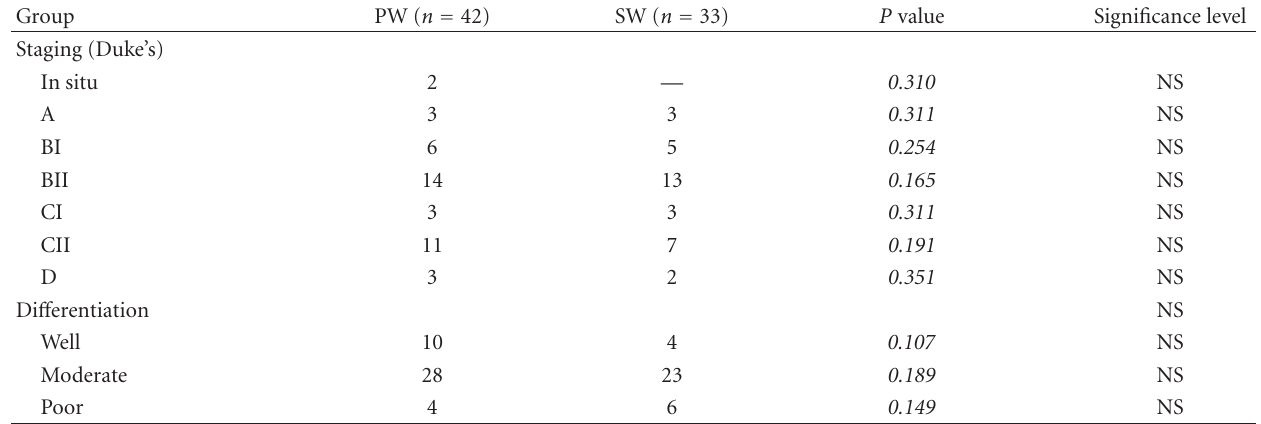
Table 3: Staging and di ff erentiation.